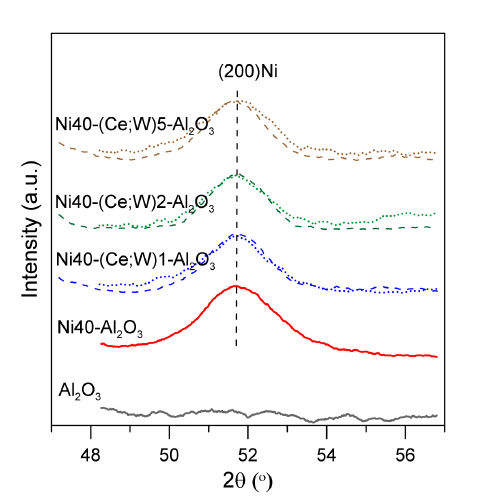
Figure 4. X-ray diffraction patterns of catalysts after reduction in selected region of 2 theta angle; Ce-promoted nickel catalysts—dotted lines, W-promoted catalysts—dashed